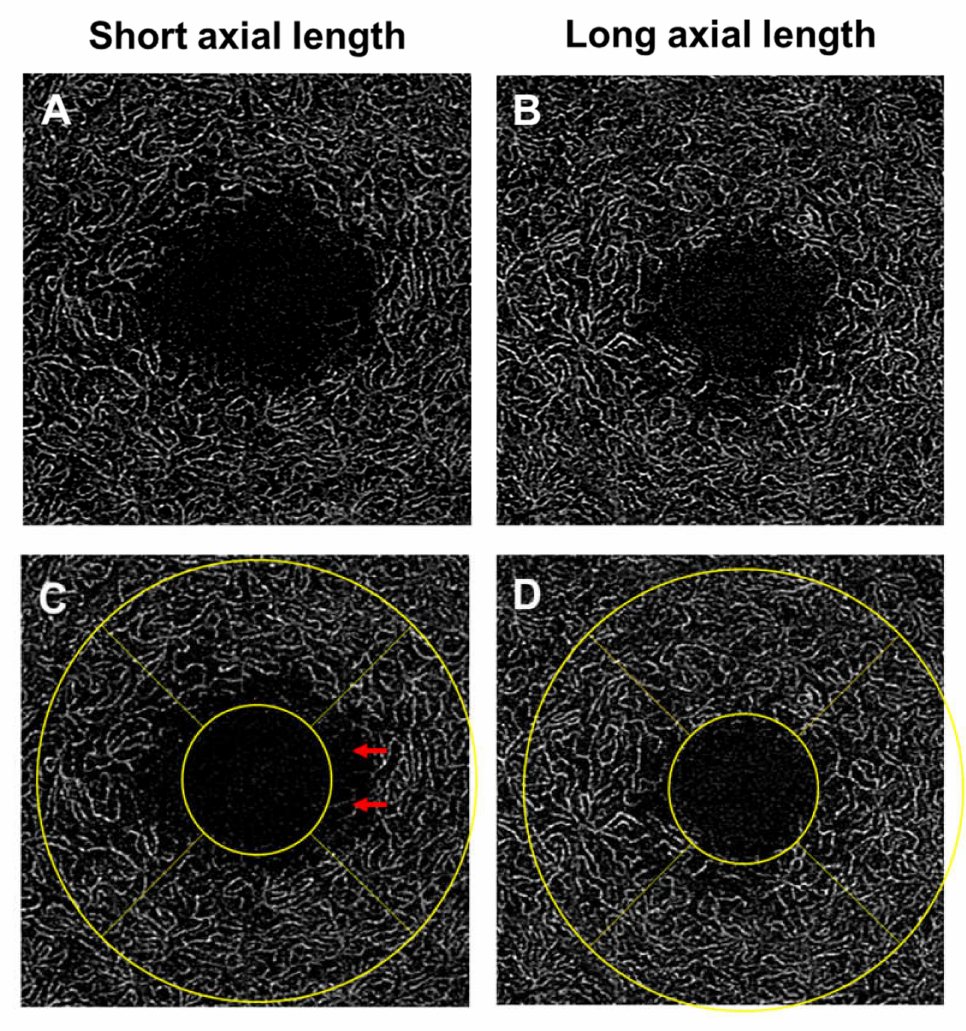
Figure 8. Optical coherence tomography angiography (OCTA; 3 × 3 mm area) of the deep vascular plexus. A hyperopic eye with spherical equivalent of + 1.00 DS and an axial length of 23.23 mm ( A , C ) and a highly myopic eye with spherical equivalent of − 10.25 DS and an axial length of 28.29 mm ( B , D ). The analytical area is defined by two concentric circles (1- and 3-mm nominal diameters) and is centered on the foveal avascular zone (FAZ). In eyes with hyperopia (shorter axial length), the OCT scan area is smaller than that of a myope. A smaller scan area would mean that the FAZ occupies a larger portion of the analytical area, resulting in a lower vessel density (red arrows). Conversely, a myopic eye (longer axial length) would have a larger scan area, ultimately an erroneously higher vessel density. Figures were created after removal of projection